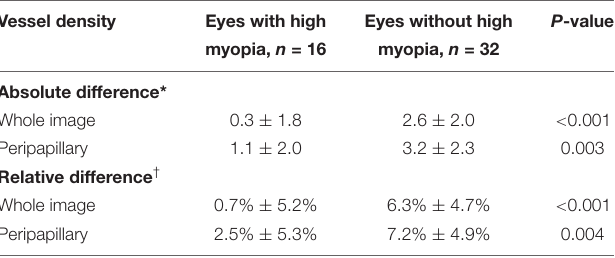
TABLE 4 | Retinal vascular response to hyperoxia in POAG eyes with and without high myopia. Vessel density Eyes with high